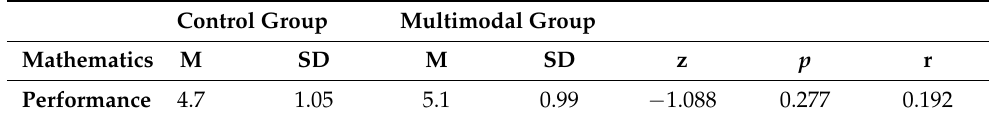
Table 13. Comparison between control and multimodal groups in the pre-test. Mathematics performance. Control Group